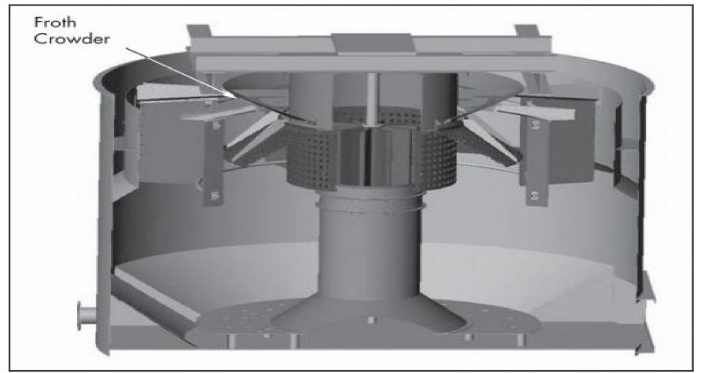
Figure 14. Froth crowder in a WEMCO ® SmartCell ® cylindrical flotation cell [85].